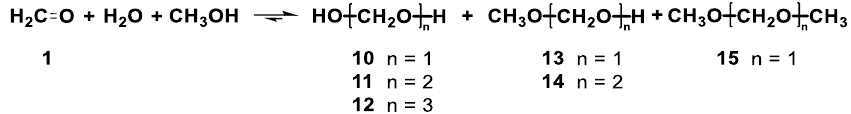
Table 1. The molar ratios of selected compounds at various temperatures for formalin in DMSO- d 6 .